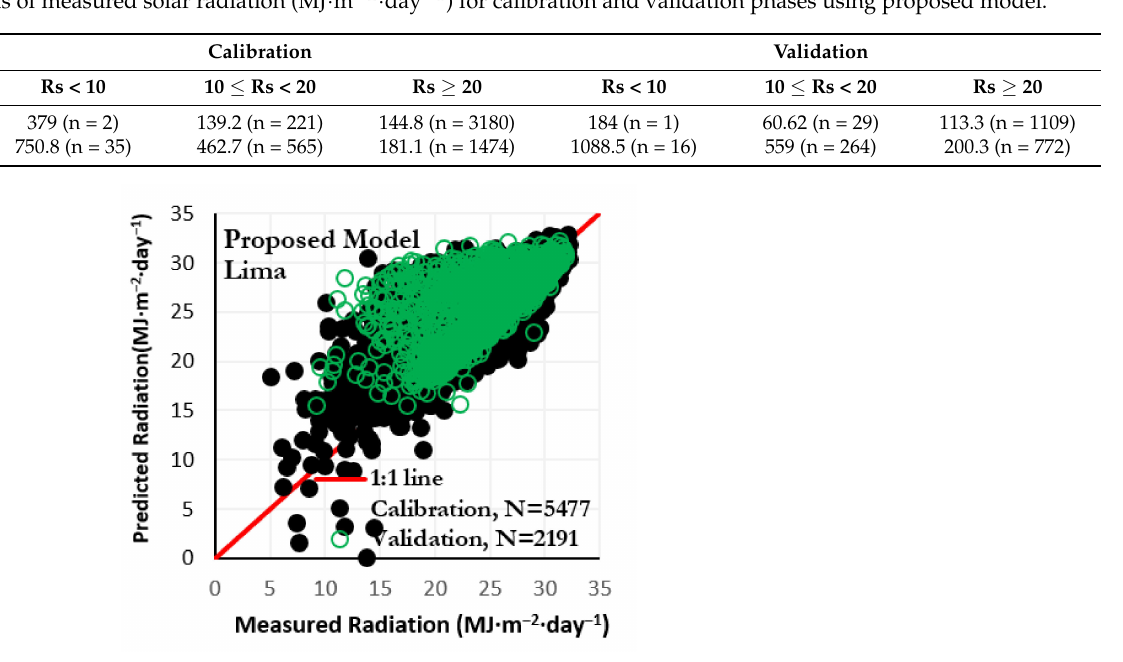
Table 13. RMSE values (J · cm − 2 · day − 1 ) and number of data points belonging to under- and overestimation sets in three defined intervals of measured solar radiation (MJ · m − 2 · day − 1 ) for calibration and validation phases using proposed model.